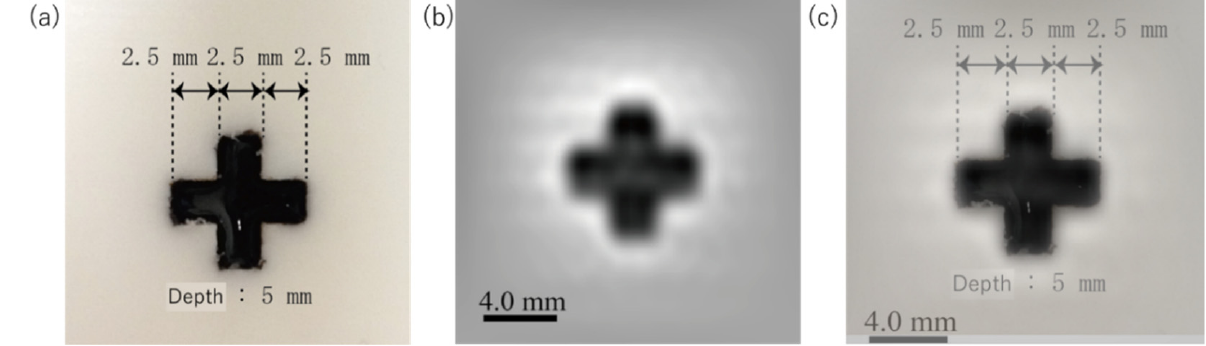
Figure 6. Comparison of the sample photo and its image reconstruction; ( c ) overlapped ( a , b ) images.